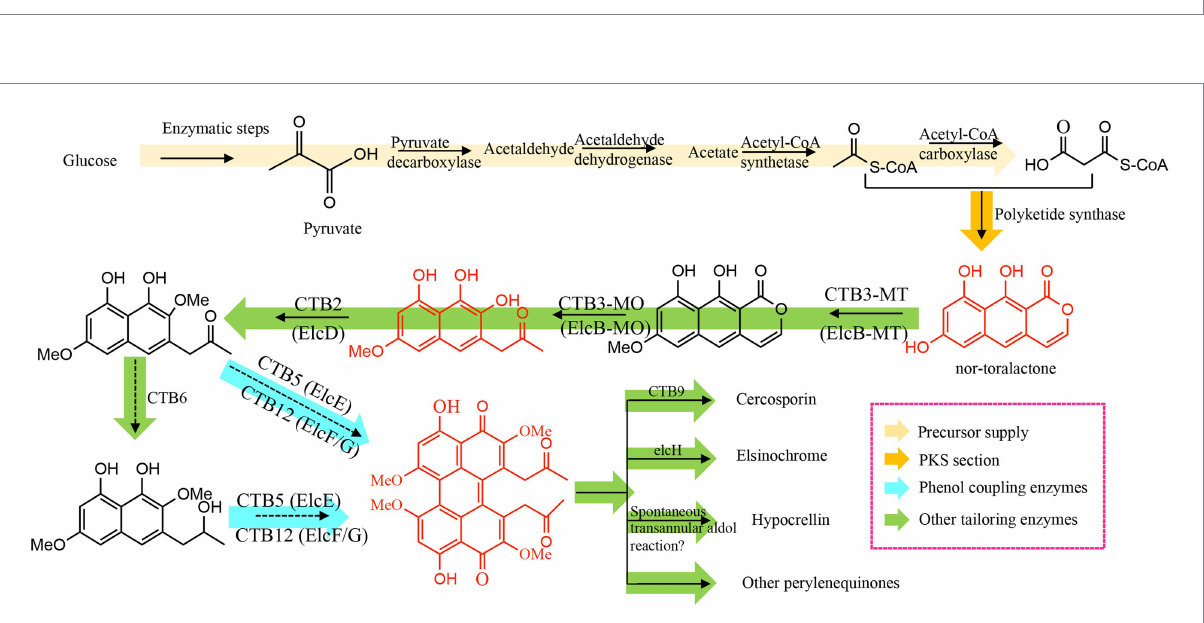
FIGURE 2 Schematic representation of perylenequinone flux using glucose as the original